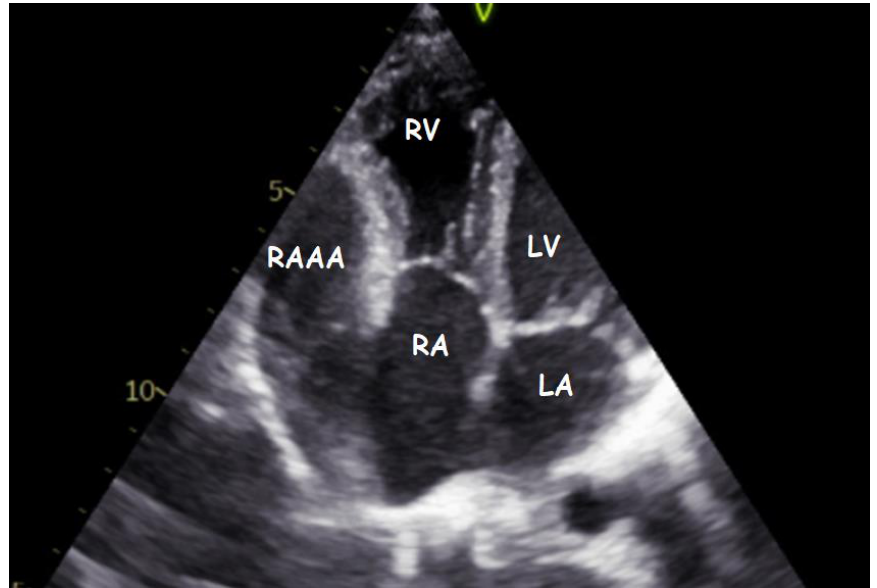
Figure 2. Transthoracic echocardiogram. Modified four-chamber view showing the gigantic RAAA ten years later.